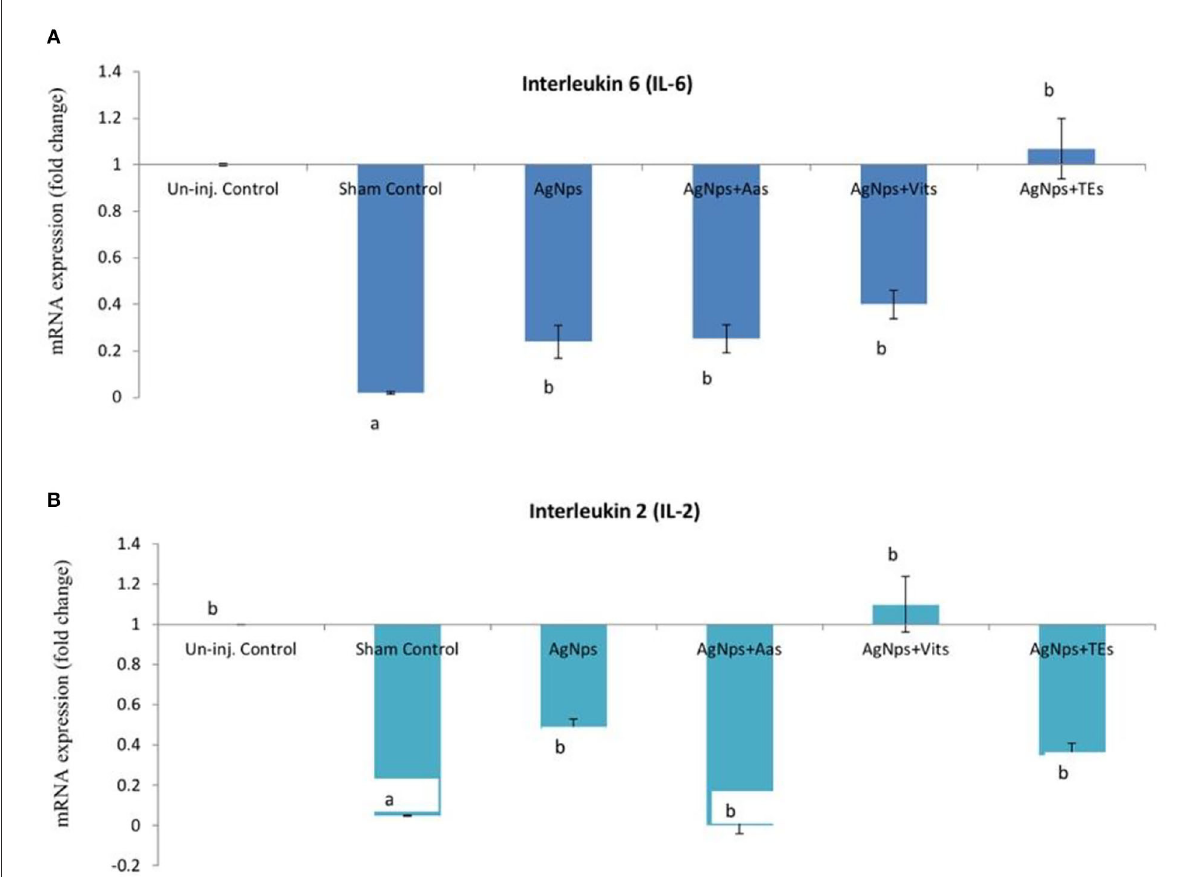
FIGURE2 Effect of in ovo administration of silver nanoparticles (AgNPs) and critical nutrients on the relative expression of IL-6 (A) and IL-2 (B) genes before virulent ND virus (vNDV) challenge. Control = un-injected, sham (sterile water), AgNPs = silver nanoparticles (50 µ g), AgNPs + AAs = silver nanoparticles (50 µ g) + amino acids (Methionine- 10mg + Arginine-25mg), AgNPs + Vits = silver nanoparticles (50 µ g) + vitamins (Vit B1-72 µ g + Vit B6-140 µ g) and AgNPs + TEs = silver nanoparticles (50 µ g) + minerals (Zn-80 µ g and Se-0.3 µ g). a,b Means bearing different alphabets in a histogram differ significantly ( P <